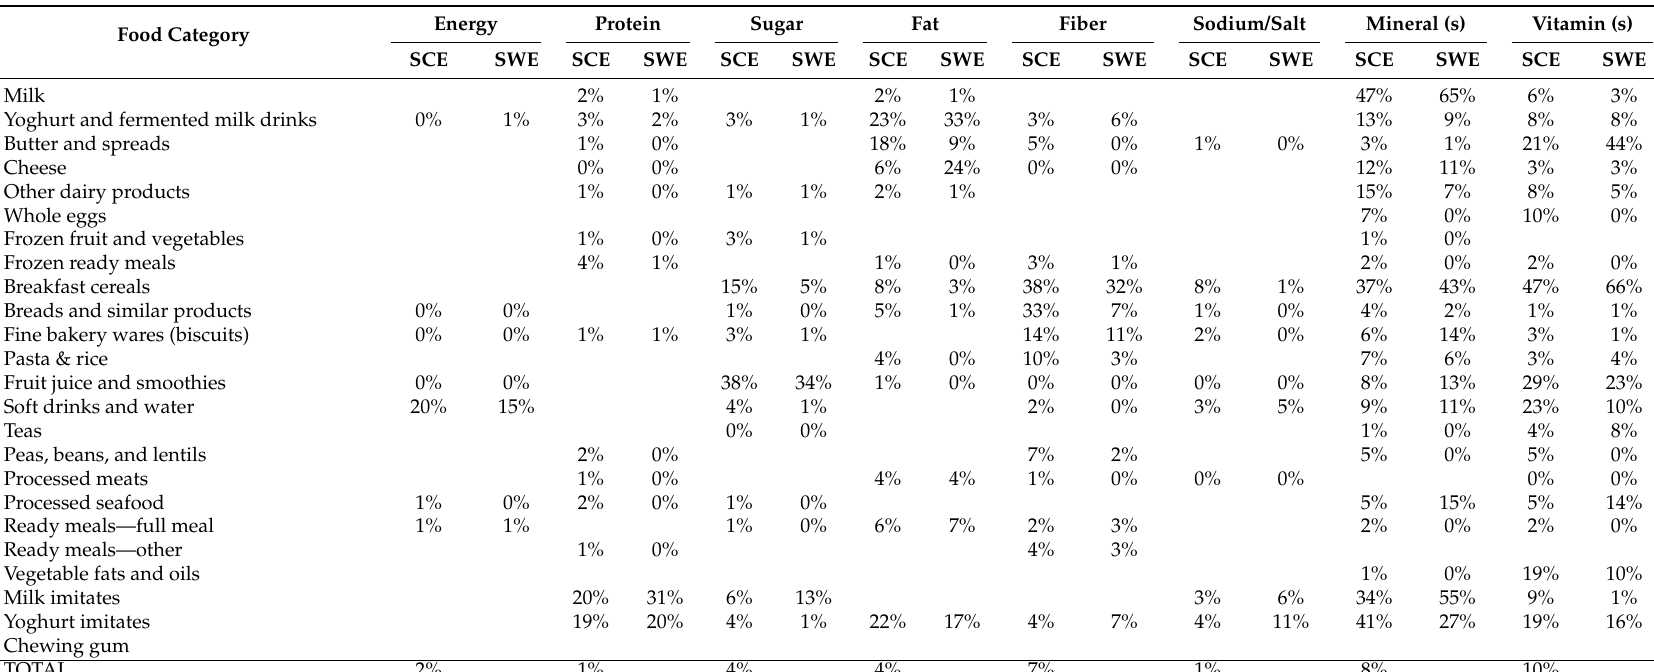
Table 3. Frequencies of common nutrients and other substances in nutrition claims per food